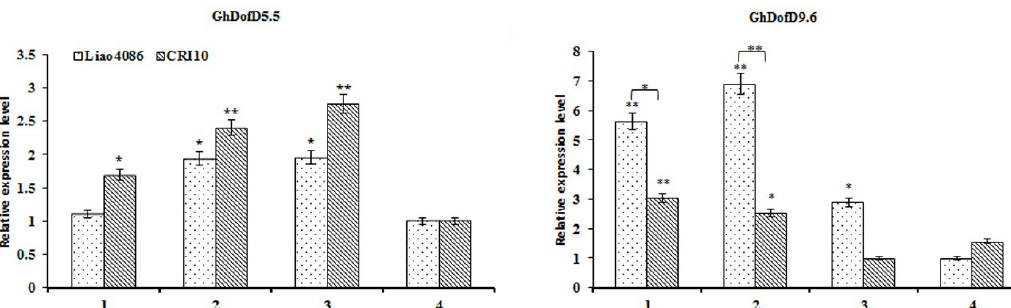
Figure 5. Gene expression patterns during cotyledon development in G. Hirsutum L. The X -axis indicates the cotyledon development stages. The numbers 1, 2, 3, and 4 indicate the samples of flattened cotyledons taken in the first week, the third week, the fifth week, and the seventh week, respectively. The Y -axis indicates relative expression level. The threshold cycle (Ct) values of all of the genes were normalized to the internal reference gene—a house-keeping gene ( GhHis ); the relative expression level was calculated by the 2 −ΔΔCt method. The bars indicate SDs. The brackets indicate the comparison between CCRI10 and Liao4086. * indicates significant differences at the p < 0.05 level. ** indicates extreme significant differences at the p < 0.01 level.